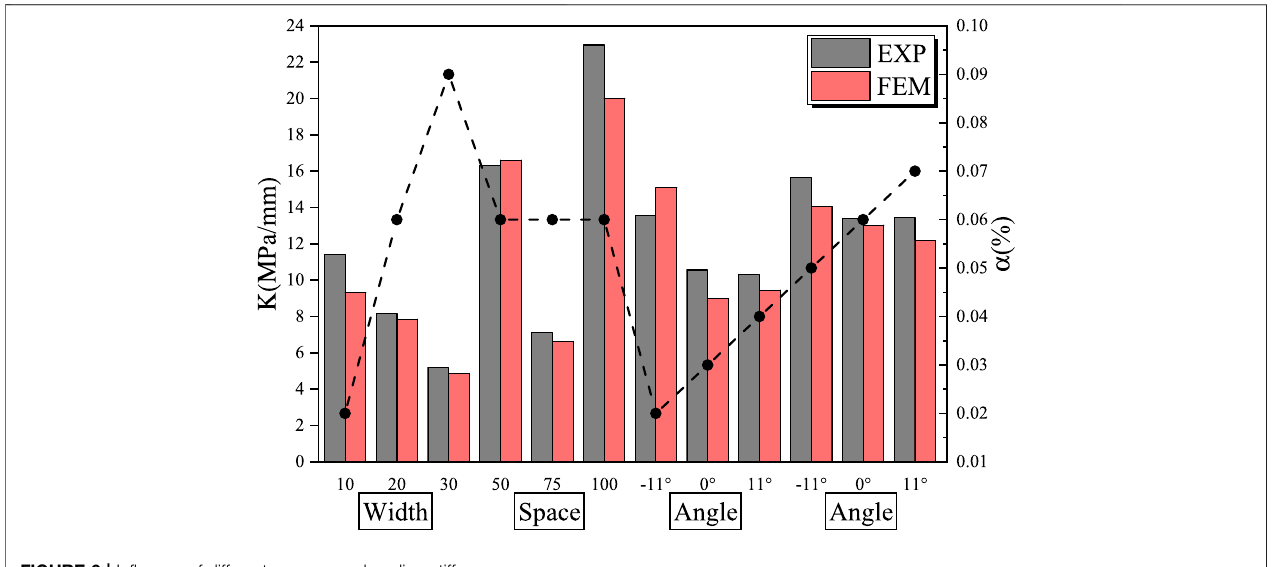
FIGURE 9 | In fl uence of different grooves on bonding